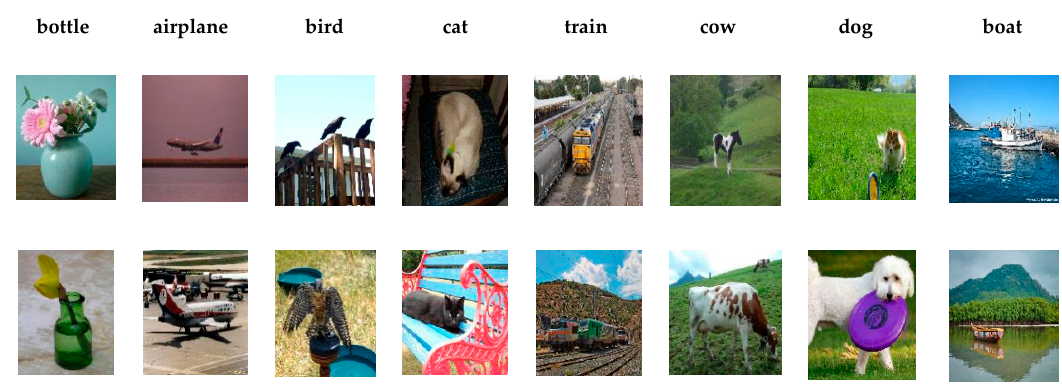
Figure 5. Some sample images in PASCAL VOC database.